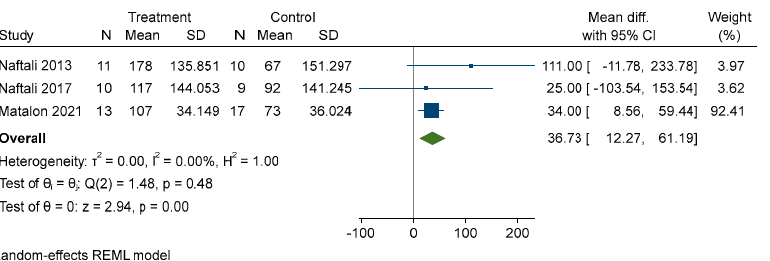
Figure 4. Forest plot of CDAI reduction. Values > 0 favors intervention, values < 0 favors control. SD: standard deviation [43–45].